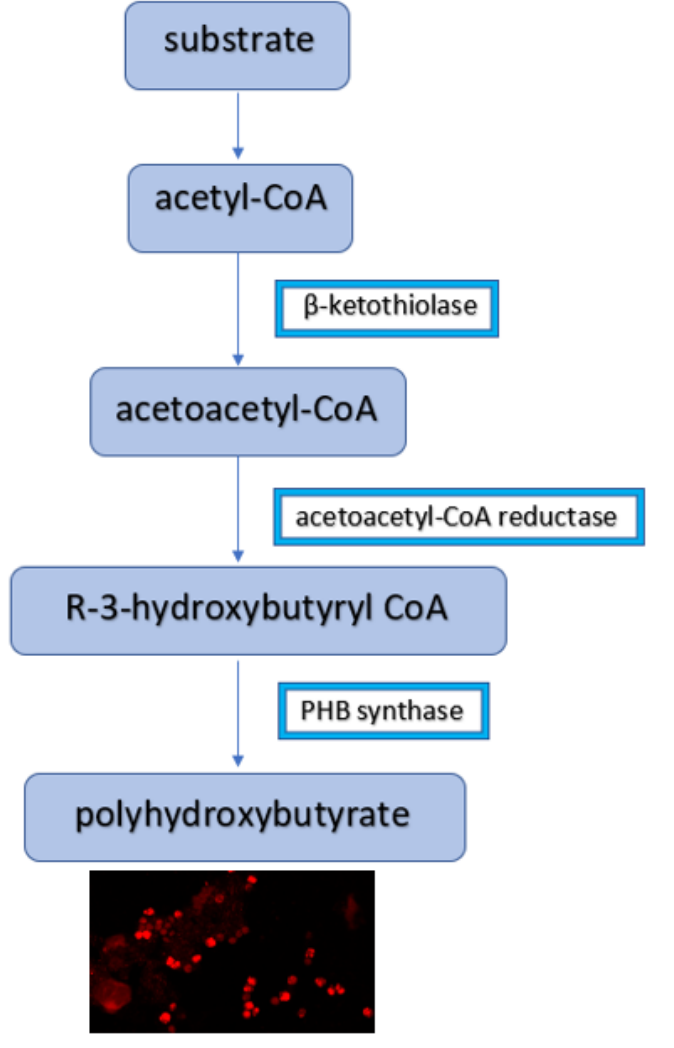
Figure 1. Scheme of PHB biosynthesis [7–11].